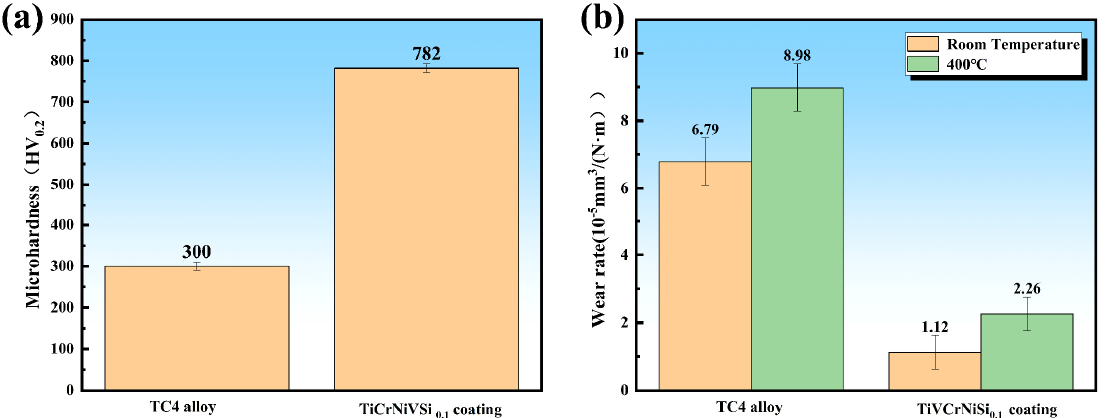
Figure 5. ( a ) Microhardness of the TC4 alloy and TiCrNiVSi0.1 coating, and ( b ) wear rate of the TiCrNiVSi 0.1 coating and TC4 alloy at room temperature and 400 °C. TiCrNiVSi 0.1 coating and TC4 alloy at room temperature and 400 ◦